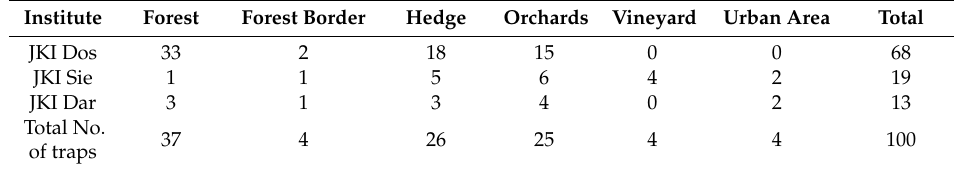
Table 1. Total number of traps per JKI site in each habitat type and the marginal sums. Institute